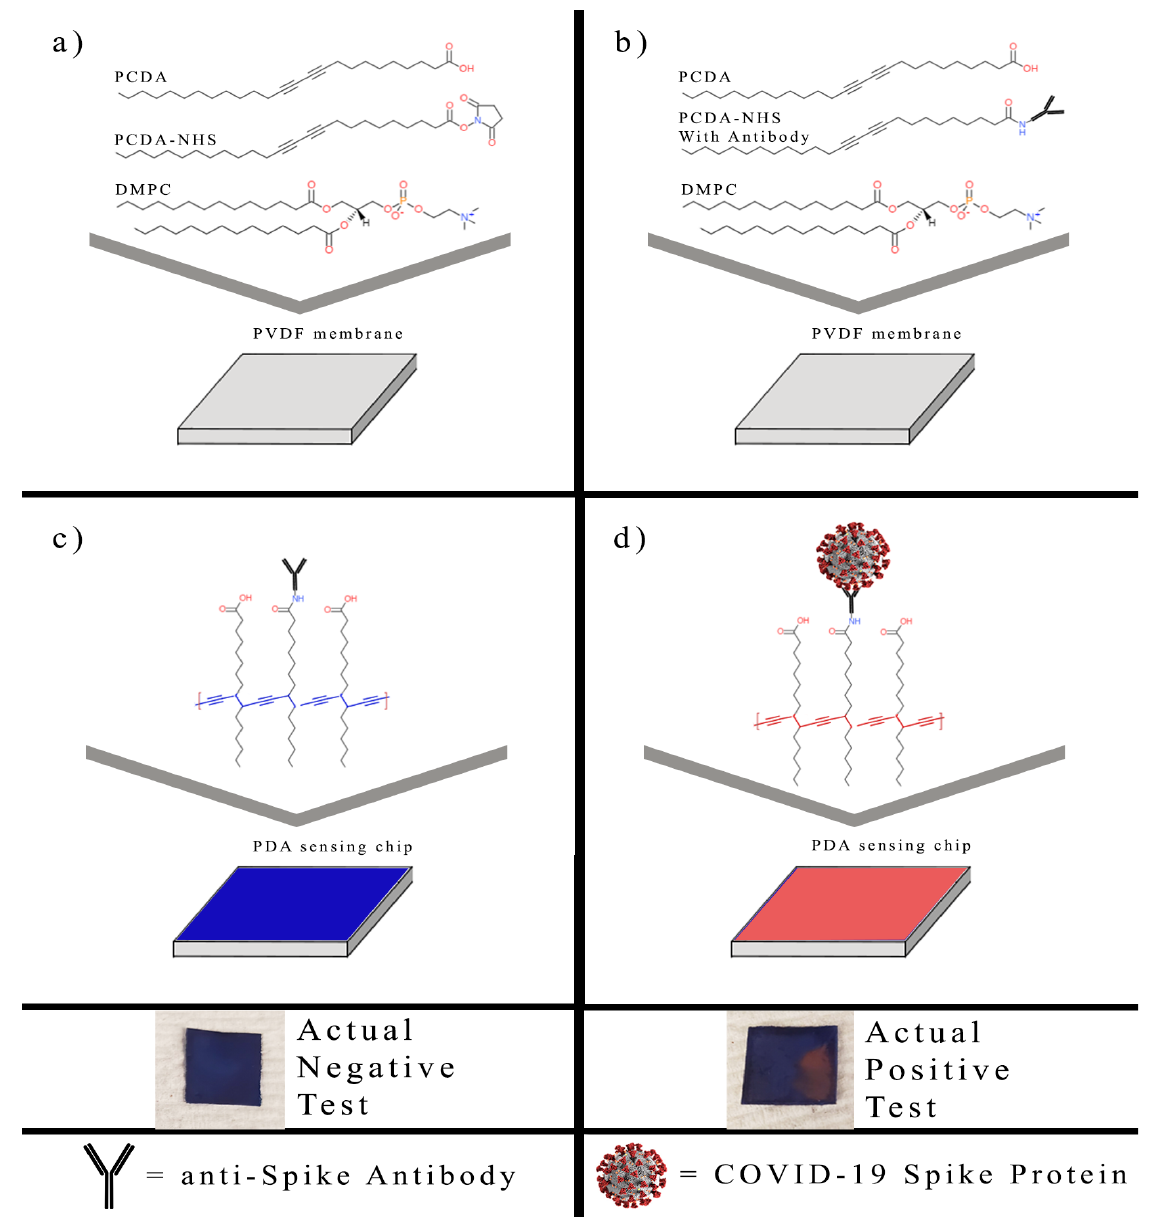
Figure 1. Creation of polydiacetylene-based sensor. PVDF membranes were dipped into the prepared chloroform solutions ( a ), incubated in solutions containing the SARS-CoV-2 spike protein antibody ( b ), photopolymerized by 254 nm UV light ( c ), and exposed to the SARS-CoV-2 spike protein in artificial saliva and PBS buffer ( d ). Images are shown of PCDA-NHS-1 sensors exposed to unmodified artificial saliva (negative test) and 1 ng/mL SARS-CoV-2 spike protein (positive test) in artificial saliva after 4 h of incubation.